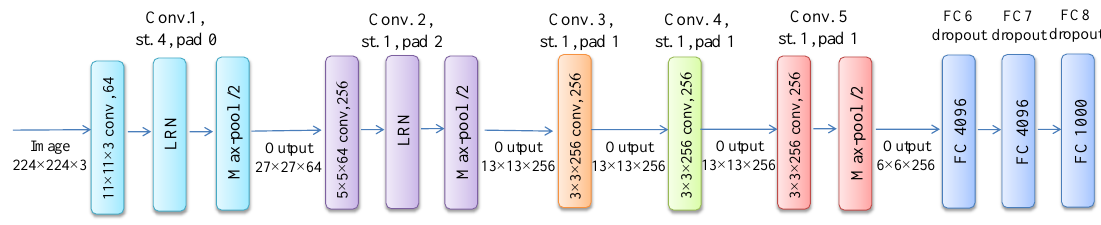
Figure 1. Chatfield’s fast convolutional neural network (CNN) architecture. Conv: convolutional layer; FC: fully connected layer; st: stride; pad: padding; LRN: local response